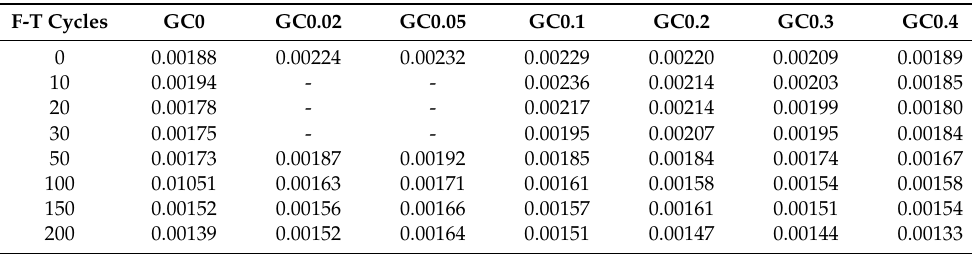
Table 4. Peak strain of concrete after F-T